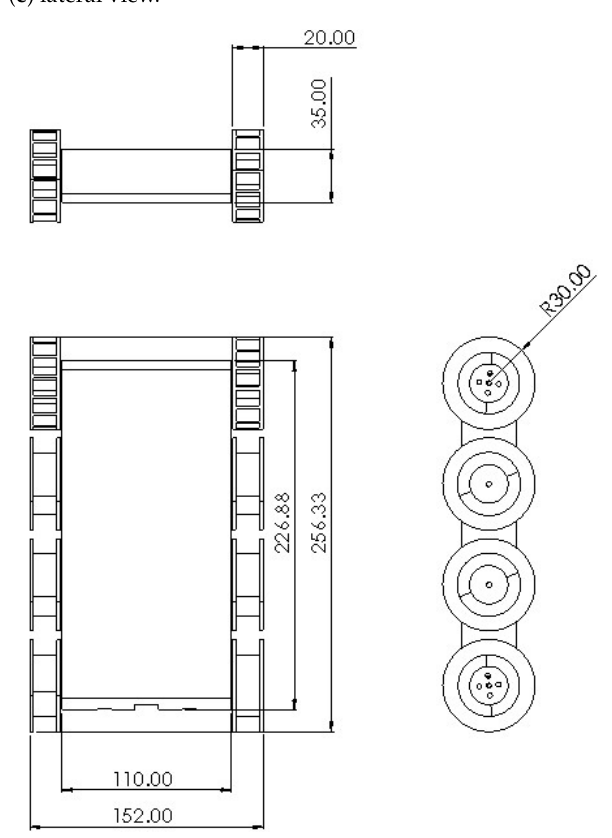
Figure 3. Dimensions of the